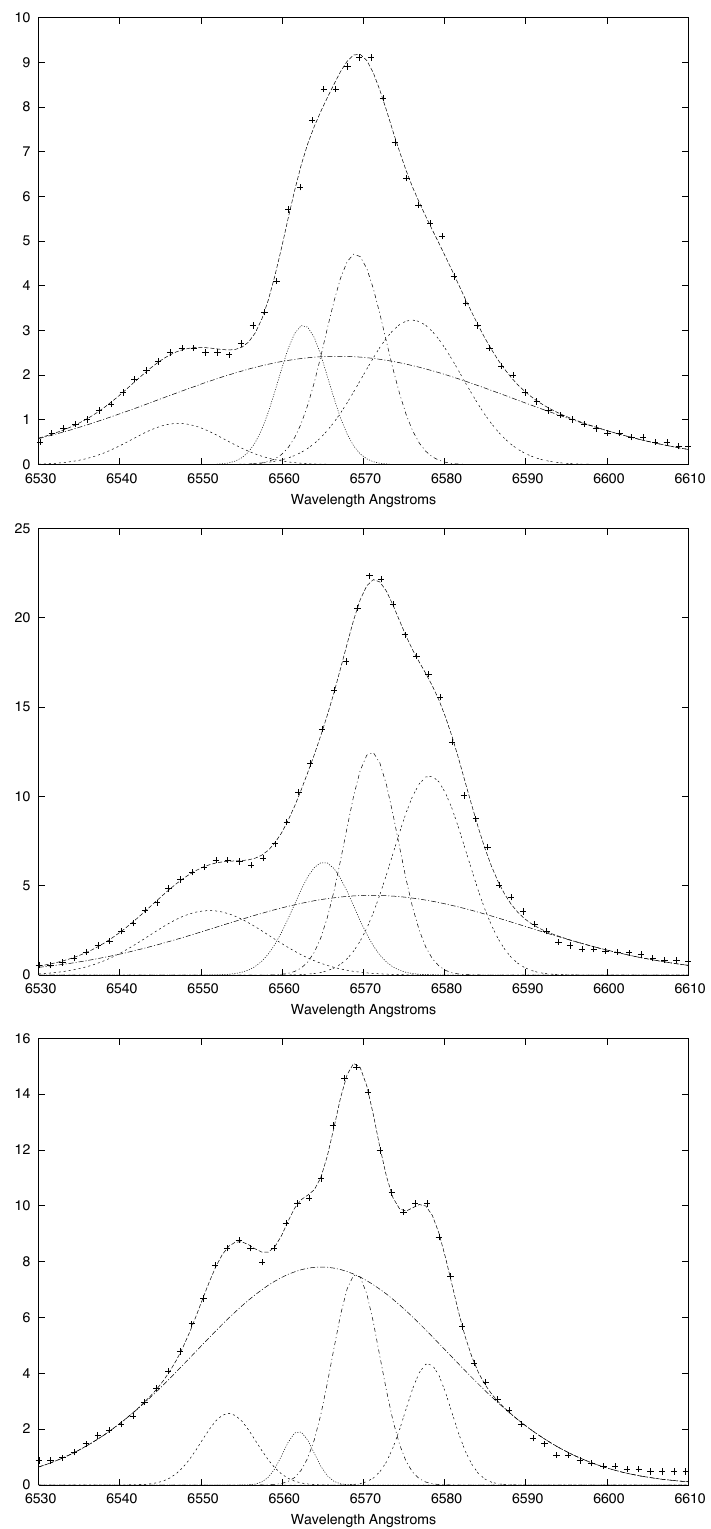
Figure 1. Three spectra of H α taken from [9], after the onset of flaring. The lowest panel is for day + 291, the middle for + 294 and the uppermost + 297. Each is decomposed into five gaussian components, with intensities normalised to the continuum, see Figure 3. The two outermost are flare, the broad central component wind and the remaining pair originate in the circumbinary disk. Day + 294 was an eclipse day; both the blue and the red flares are substantial, having roughly twice the normalised